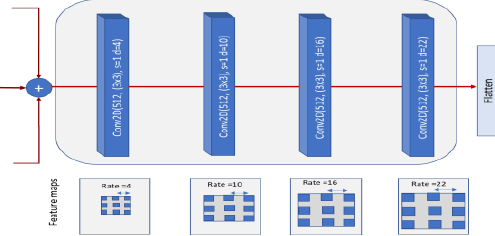
Figure 7. Atrous spatial pyramid pooling module ( ASPP ) replaced the Conv2D layer after concate- nating the features in Figure 5. It includes four Conv2D with different dilation rates 4, 10, 16, 22, respectively, and associated feature maps.